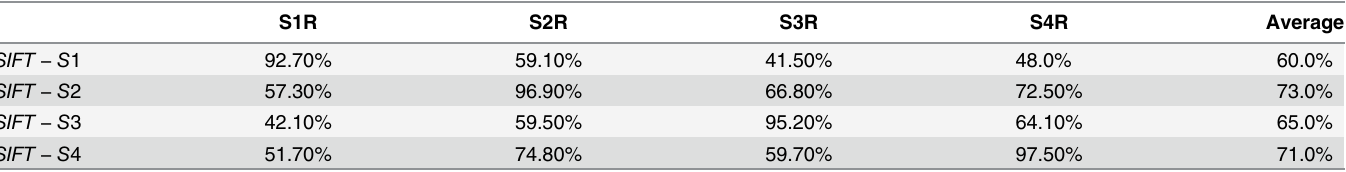
Sizes S1R, S2R, S3R and S4R with rotated ligatures are shown along x-axis, as a test data. The correct classi fi cation rate (%) is shown along x-axis for each distinct SIFT descriptor